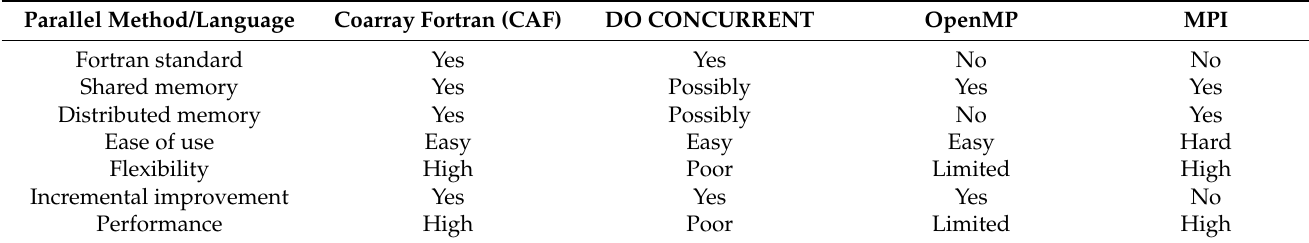
Table 1. Comparison of features of the parallel processing methods